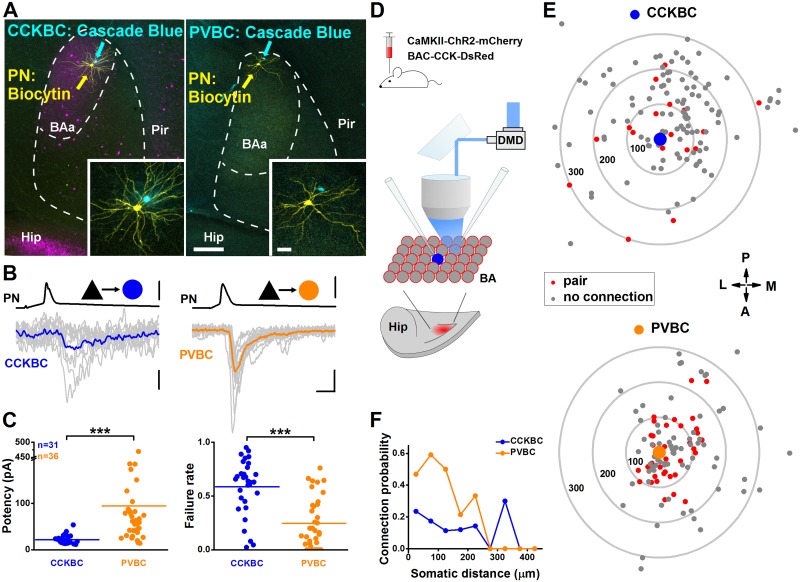
Principle neurons (PNs) give rise to distinct excitatory synaptic inputs onto the 2 basket cell (BC) types.(A) Panoramic images showing a cholecystokinin-expressing basket cell (CCKBC)→PN (left) and a parvalbumin-containing basket cell (PVBC)→PN (right) pair in the anterior part of the basal amygdala (BA). Interneurons were filled with Cascade Blue and PNs with biocytin. Insets show a higher magnification of the cell pairs recorded. Scales: 250 μm. (B) Representative traces of unitary excitatory postsynaptic currents (EPSCs) evoked by action potentials in a PN→CCKBC (upper traces) and a PN→PVBC pair (lower traces). Ten superimposed consecutive traces are in gray, and averages are in blue and orange. Scales: x: 2 ms; PN→CCKBC, y: 80 mV/8 pA; PN→PVBC, y: 90 mV/30 pA. (C) PVBCs receive unitary excitatory postsynaptic currents (uEPSCs) from local PNs with larger amplitude and lower failure rate than CCKBCs (potency, CCKBC: 21.5 ± 1.6 pA, PVBC: 94.25 ± 15.08 pA; failure rate, CCKBC: 0.58 ± 0.04, PVBC: 0.25 ± 0.04; Mann–Whitney U test, ***p < 0.001) (S6 Data). Each data point on the plots represents an average obtained in a pair recording, and lines represent means. (D) Schematic illustration of the experimental design to excite PNs using blue light. mCherry-containing construct was injected into the BA of transgenic mice (bottom drawing illustrates a horizontal slice showing the expression site in red). Among adeno-associated virus (AAV)-infected PNs (red circles), a CCKBC (blue) was recorded in whole-cell mode, while its excitatory input from neighboring PNs was tested by light illumination and/or whole-cell recording. BA, basal amygdala; Hip, hippocampus. (E) Connectivity map. Concentric circles indicate Δ100 μm distance from the interneuron in the center (S6 Data). Each dot represents a tested PN soma location. (F) PVBCs receive excitatory synaptic inputs from their neighboring PNs with high probability, while CCKBCs are innervated by PNs via their local collaterals with low probability, independently of the inter-somatic distance (S6 Data).